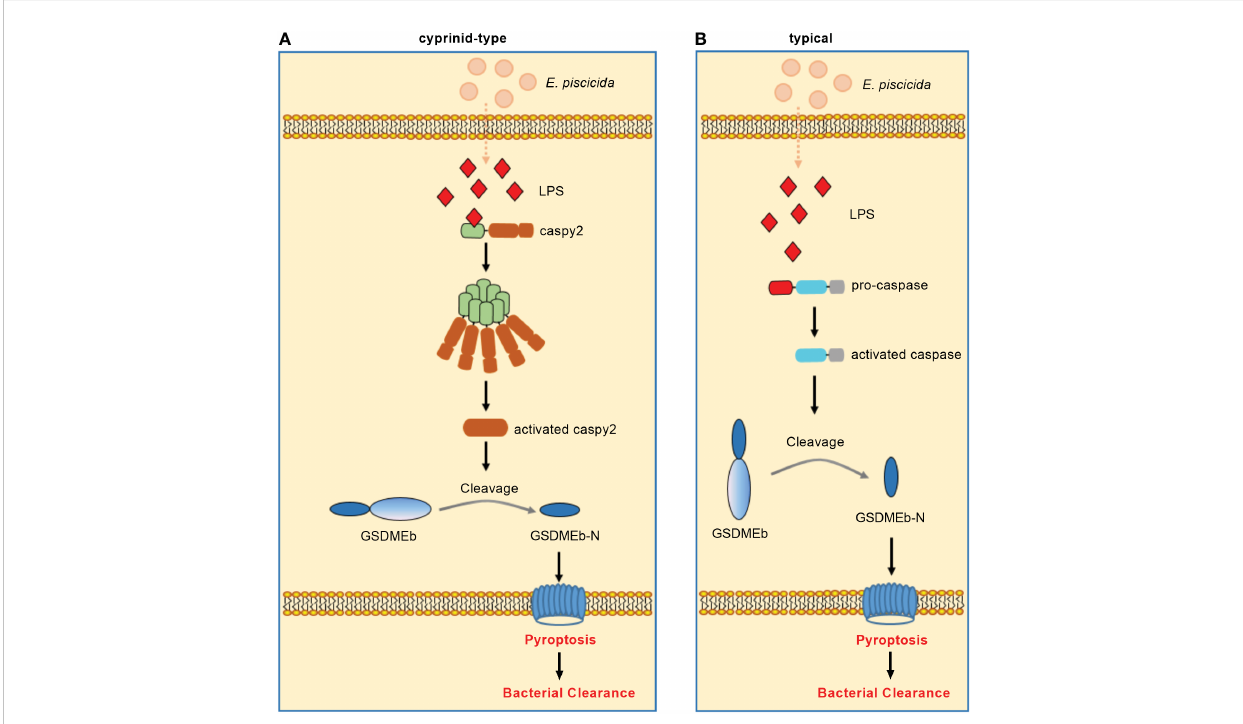
FIGURE 3 Non-canonical in fl ammasome activation in teleost fi sh. (A) Non-canonical in fl ammasome activation in cyprinids. Zebra fi sh caspy2 binds directly to LPS, resulting in caspy2 oligomerization, which is critical for cleaving GSDMEb to elicit pyroptosis. The caspy2 – GSDMEb axis-mediated neutrophil pyroptosisgated NET formation, namely noncanonical NETosis, played a critical role in bacterial clearance. (B) Non-canonical in fl ammasome activation in other fi sh species. In the turbot, the in fl ammatory caspase can directly recognize cytosolic LPS, resulting in the GSDMEb cleavage- gated pyroptosis and bacterial